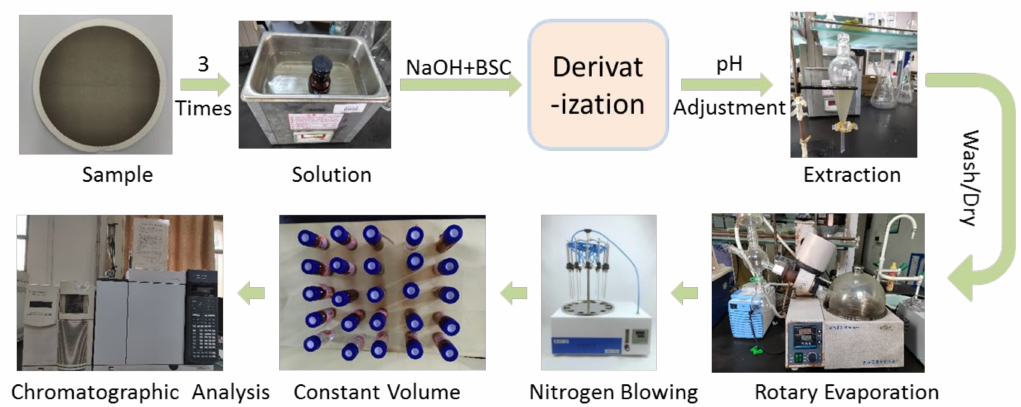
Figure 3. Sample pretreatment